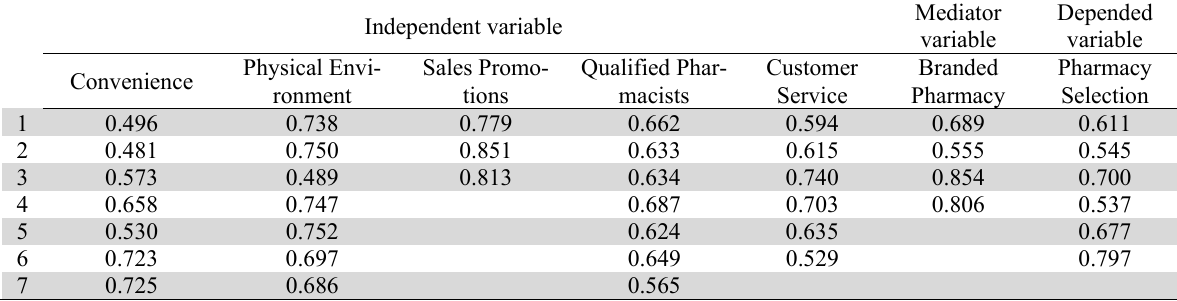
Reliability analysis using Cronbach alpha for internal consistency